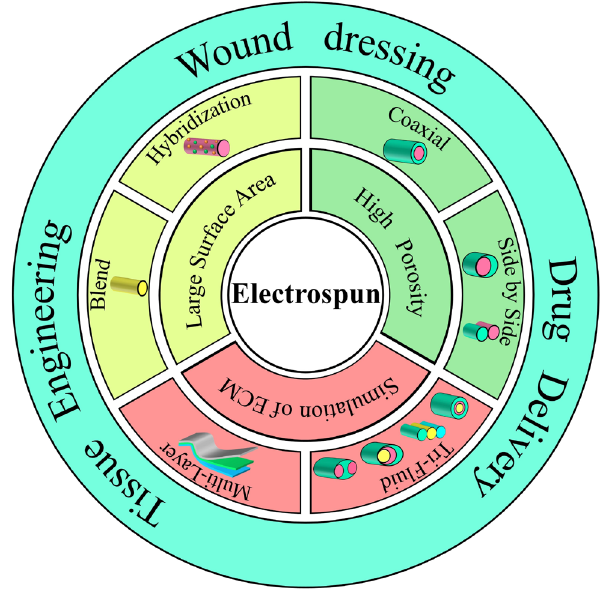
Figure 1. Characteristics, common structures of electrospun nanofibers and applications in the medical field.